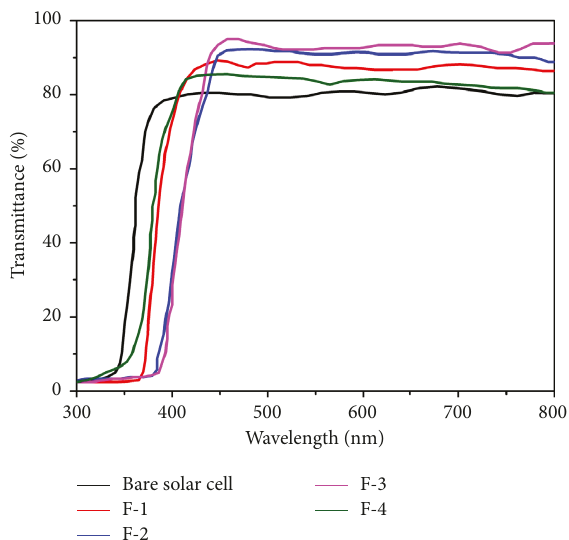
Figure 7: Transmittance of various coated